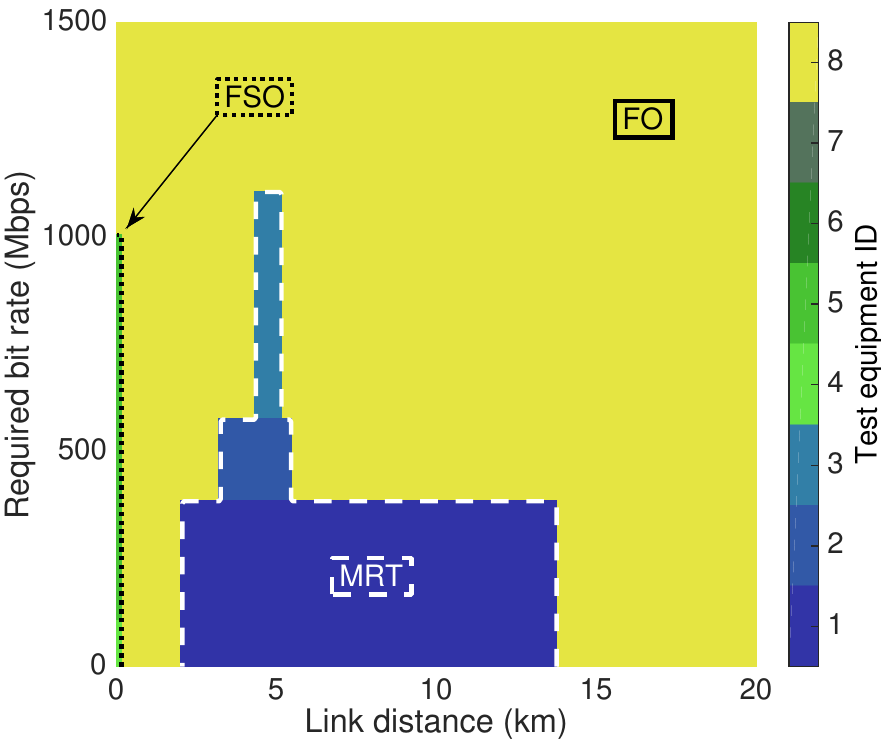
Figure 7. Cost-effective solutions for